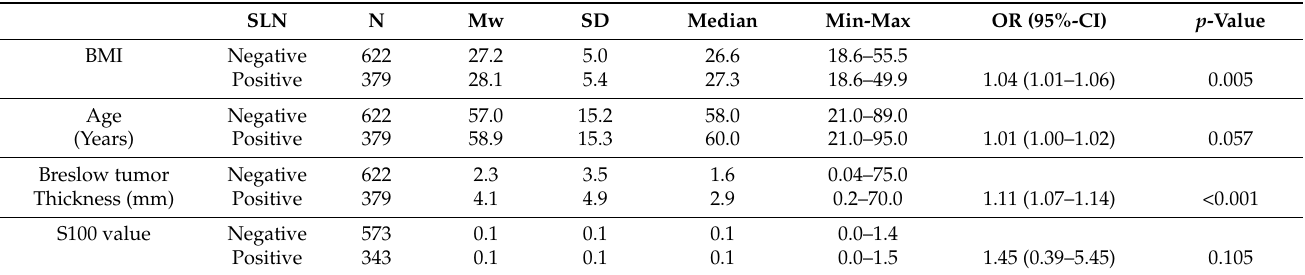
Table 5. Metastases in the sentinel lymph node biopsy—metric characteristics.